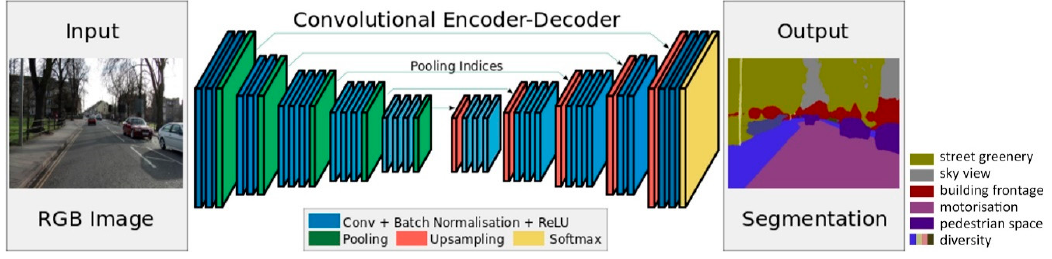
Figure 6. A schematic architecture of SegNet [39].